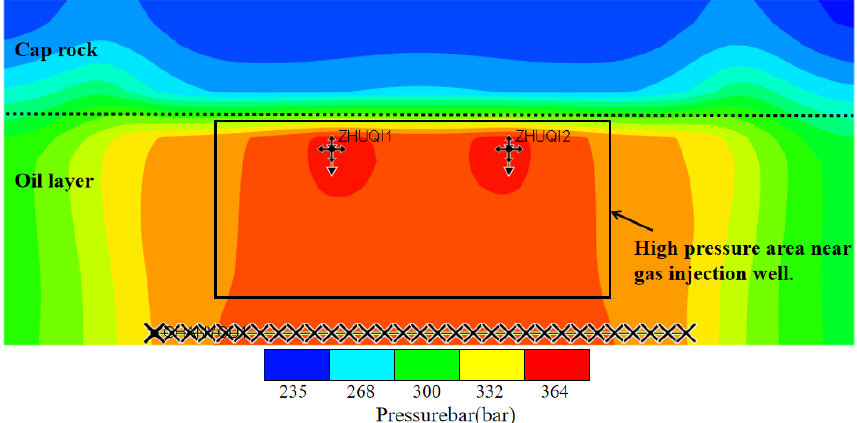
Figure 9. Case 1 pressure distribution in the seventh year of operation.